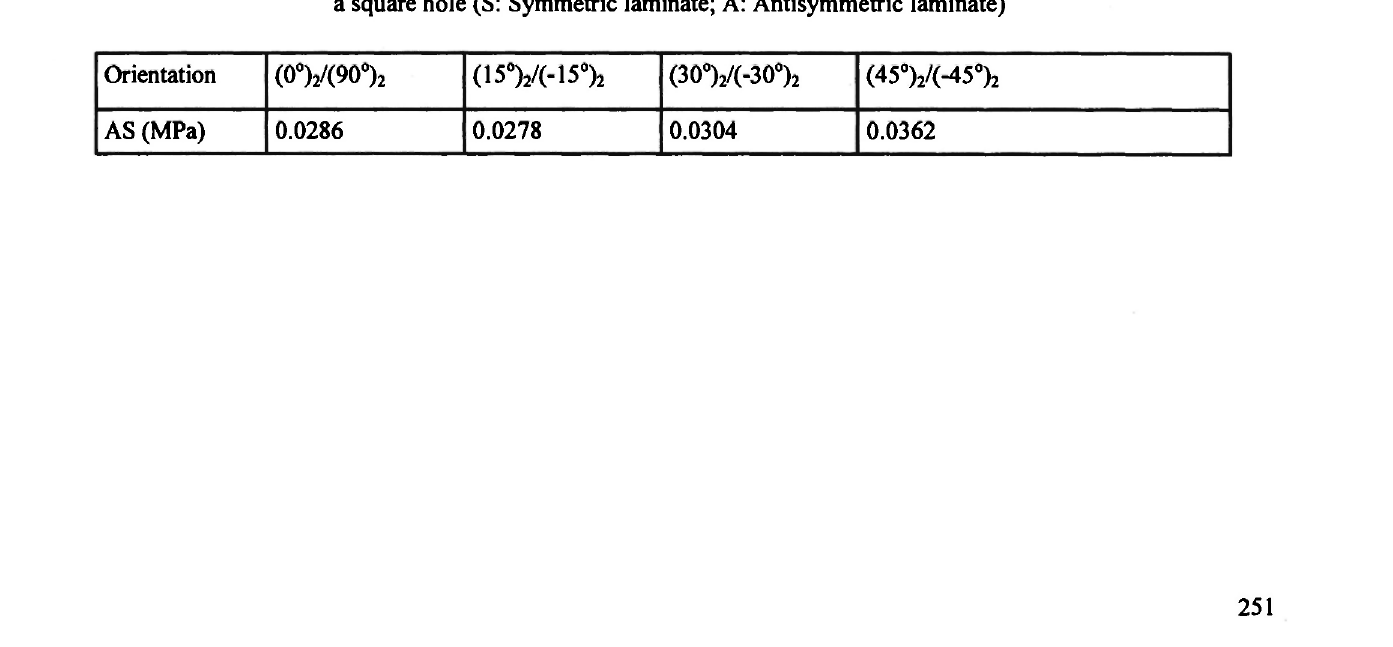
The uniform transverse force at the yield points of symmetric and antisymmetric simple supported laminated plates with a square hole (S: Symmetric laminate; A: Antisymmetric